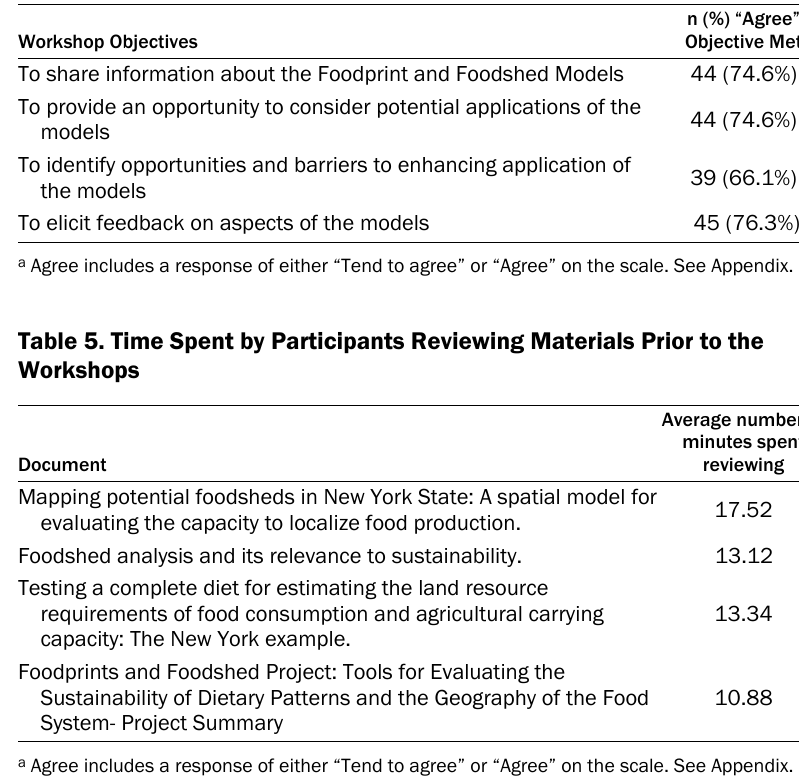
Table 4. Number and Percent of Participants “Agreeing” Workshop